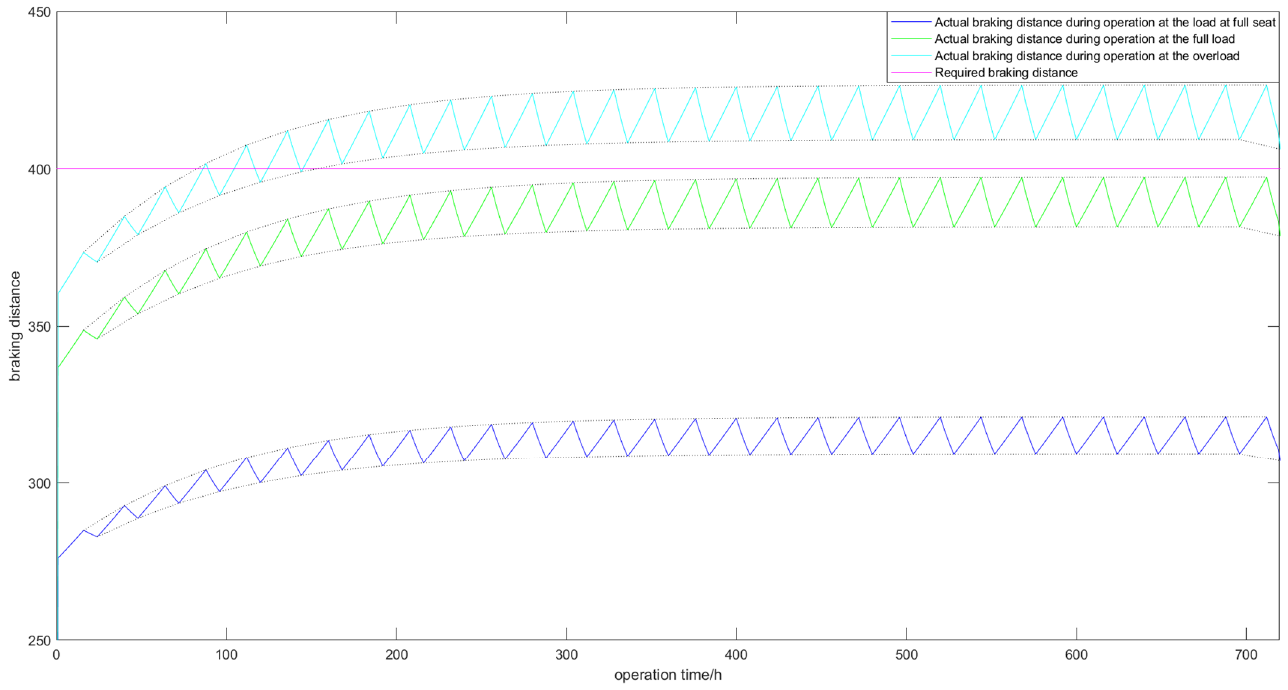
Figure 5. Braking distance under different loads during an overhaul interval.